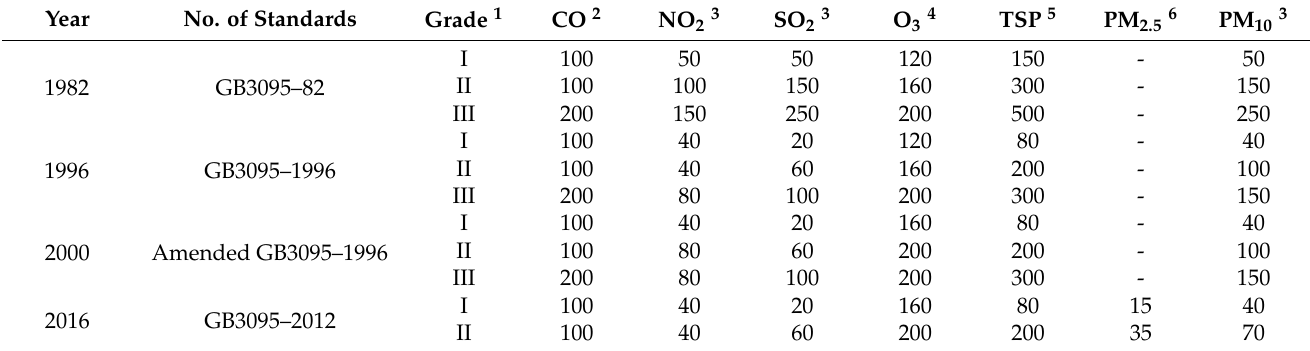
Table 3. National Ambient Air Quality Standards (NAAQSs) of China